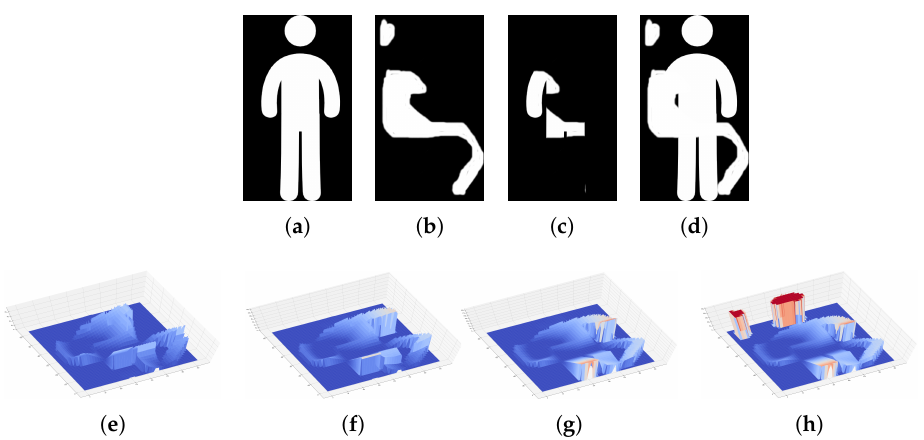
Figure 3. Illustration of the wave propagation; ( a ) input A; ( b ) input B; ( c ) intersection; ( d ) union; ( e ) wave 100 iterations; ( f ) wave 150 iterations; ( g ) wave 300 iterations; ( h ) wave unreached